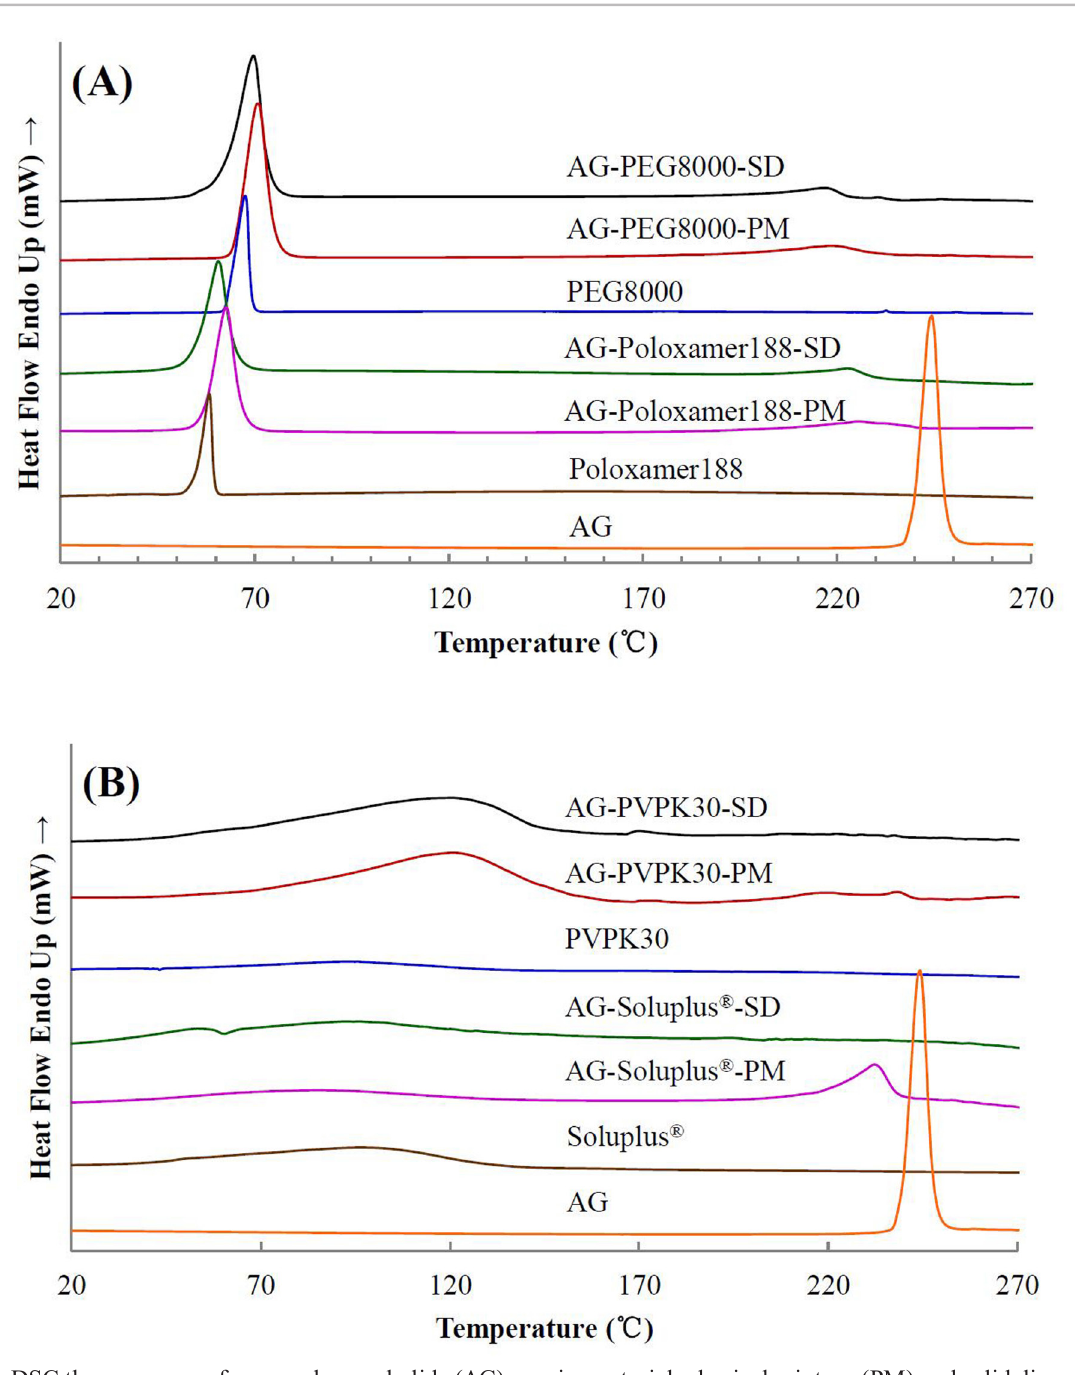
FIGURE 3 - DSC thermograms of pure andrographolide (AG), carrier material, physical mixture (PM) and solid dispersion (SD) (A) PEG8000 and Poloxamer188 as carrier materials, (B) PVPK30 and Soluplus ® as carrier